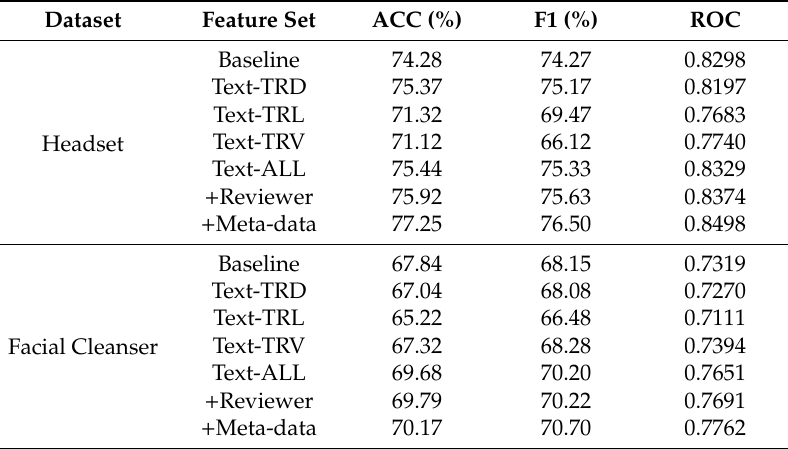
Table 6. Evaluations of the feature